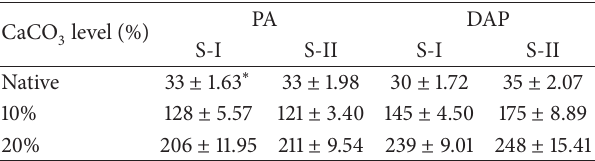
O (kg ha − 1 ) required to achieve 0.2 mgL − 1 2 5